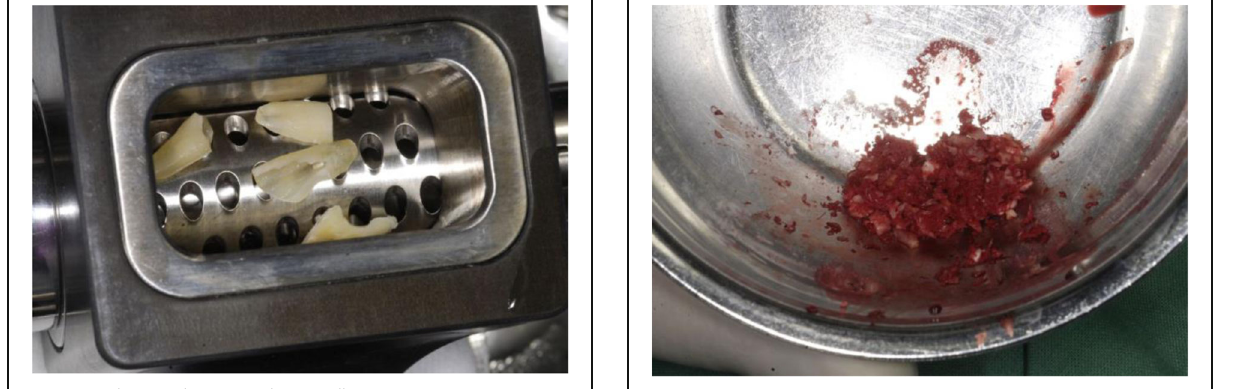
Fig. 7 Autologous, particulated dentin mixed with blood from the operating site